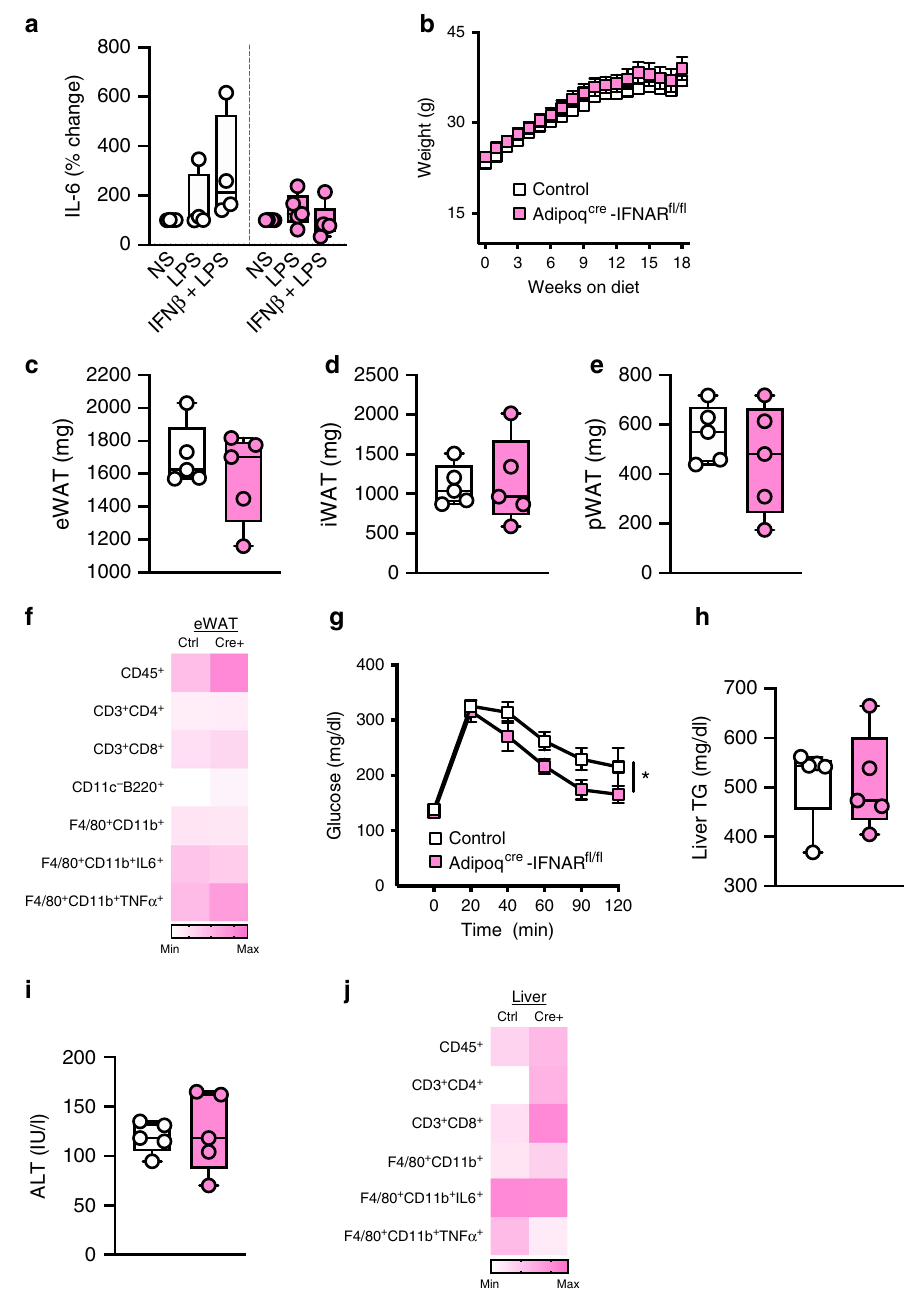
Fig. 6 Adipocyte-intrinsic IFNAR axis is a contributor to the severity of obesity-associated sequelae. a − j Adipoq cre IFNAR fl / fl and littermate controls (Cre − IFNAR fl / fl ) were fed HFD for 18 weeks. a IL-6 protein in the supernatant of visceral adipose tissue-derived mature adipocytes stimulated under indicated conditions quanti fi ed by ELISA, % change to NS. b Total body weight. c eWAT, d iWAT, e pWAT weights. f Average eWAT immune cell in fi ltration, measured by fl ow cytometry. g Glucose tolerance test. h Liver triglycerides. i Systemic ALT quanti fi ed at time of harvest. j Average liver immune cell in fi ltration measured by fl ow cytometry. a Data combined from two independent experiments, n = 4 − 5/condition. b − j Representative of two independent experiments, n = 5/condition. a , c − e , h − i For box plots, the midline represents the mean, boxes represent the interquartile range and whiskers show the full range of values. b , f , g , j For line graphs and heat maps, data represent mean ± SEM. a , c − f , h − j Unpaired two-tailed Student ’ s t test. b , g Area under curve. * P < 0.05. Source data are provided as a Source data fi